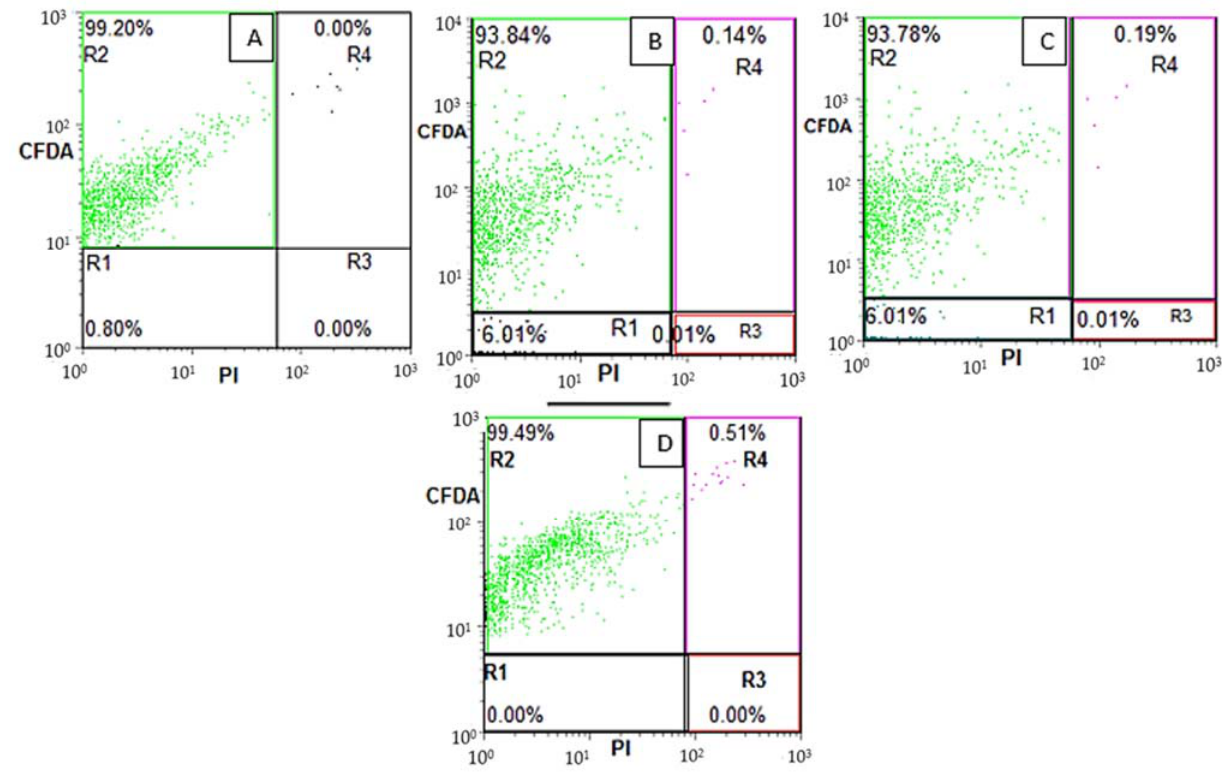
Figure 3. Flow cytometric dot plots of B. breve upon treatment with 0 ( A ), 300 ( B ), 600 ( C ) and 900 ( D ) µ m EU nano-emulsion after 36 h of treatment. R1 (cell debris), R2 (viable cells), R3 (membrane-damaged cells) and R4 (sub-lethal cells).